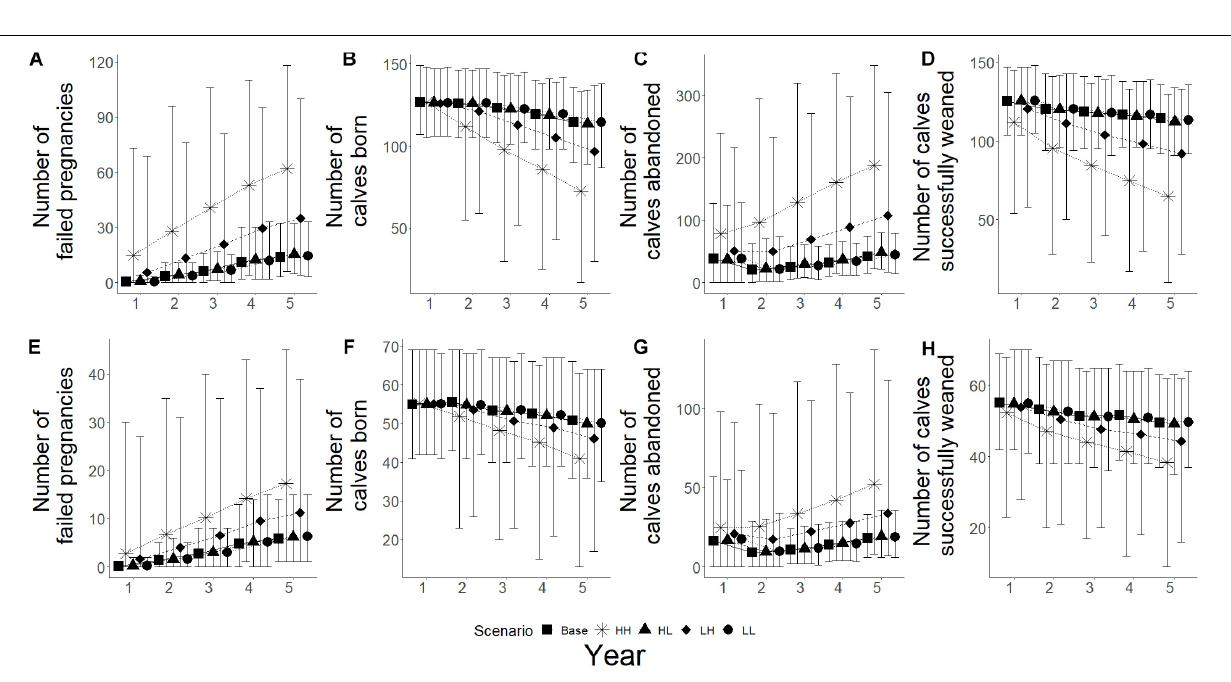
FIGURE 6 | Reproductive parameters under epizootic simulations for both populations. Five scenarios presented with base ( (cid:4) ), HH – high frequency/high impact ( ∗ ), HL – high frequency/low impact ( (cid:78) ), LH – low frequency/high impact ( (cid:7) ), and LL – low frequency/low impact ( represents Gulf St Vincent. (A,E) Shows the mean number of failed pregnancies for each scenario; figures ( B,F ) show mean number of calves born; (C,G) shows the mean number of abandoned calves; and (D,H) shows the mean number of calves that survived to weaning.